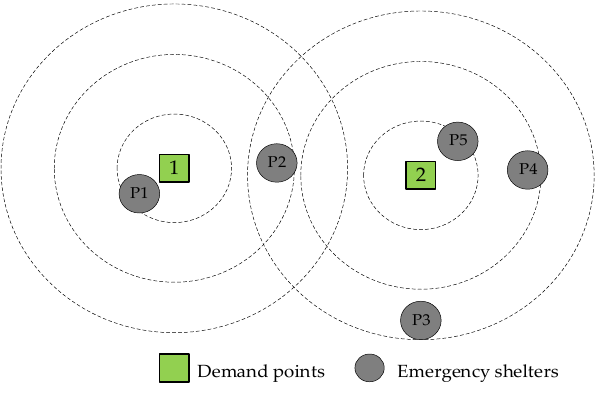
Figure 3. Multi-level coverage function.